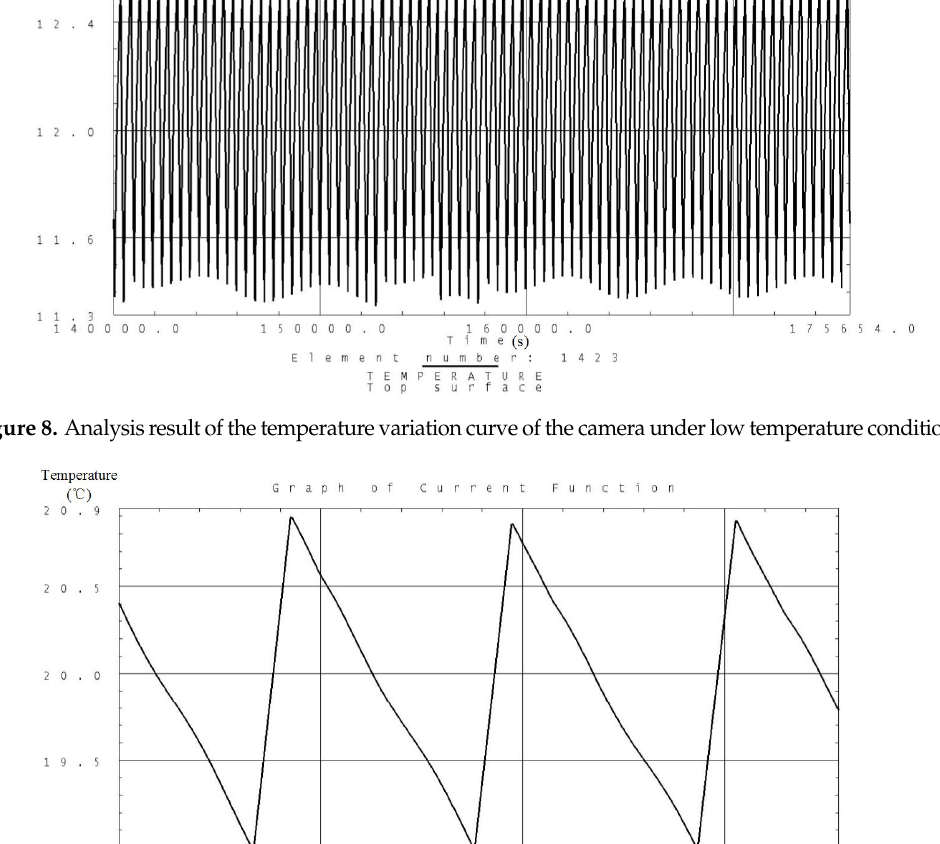
Figure 10. Analysis result of the temperature variation curve of the battery under low temperature conditions.